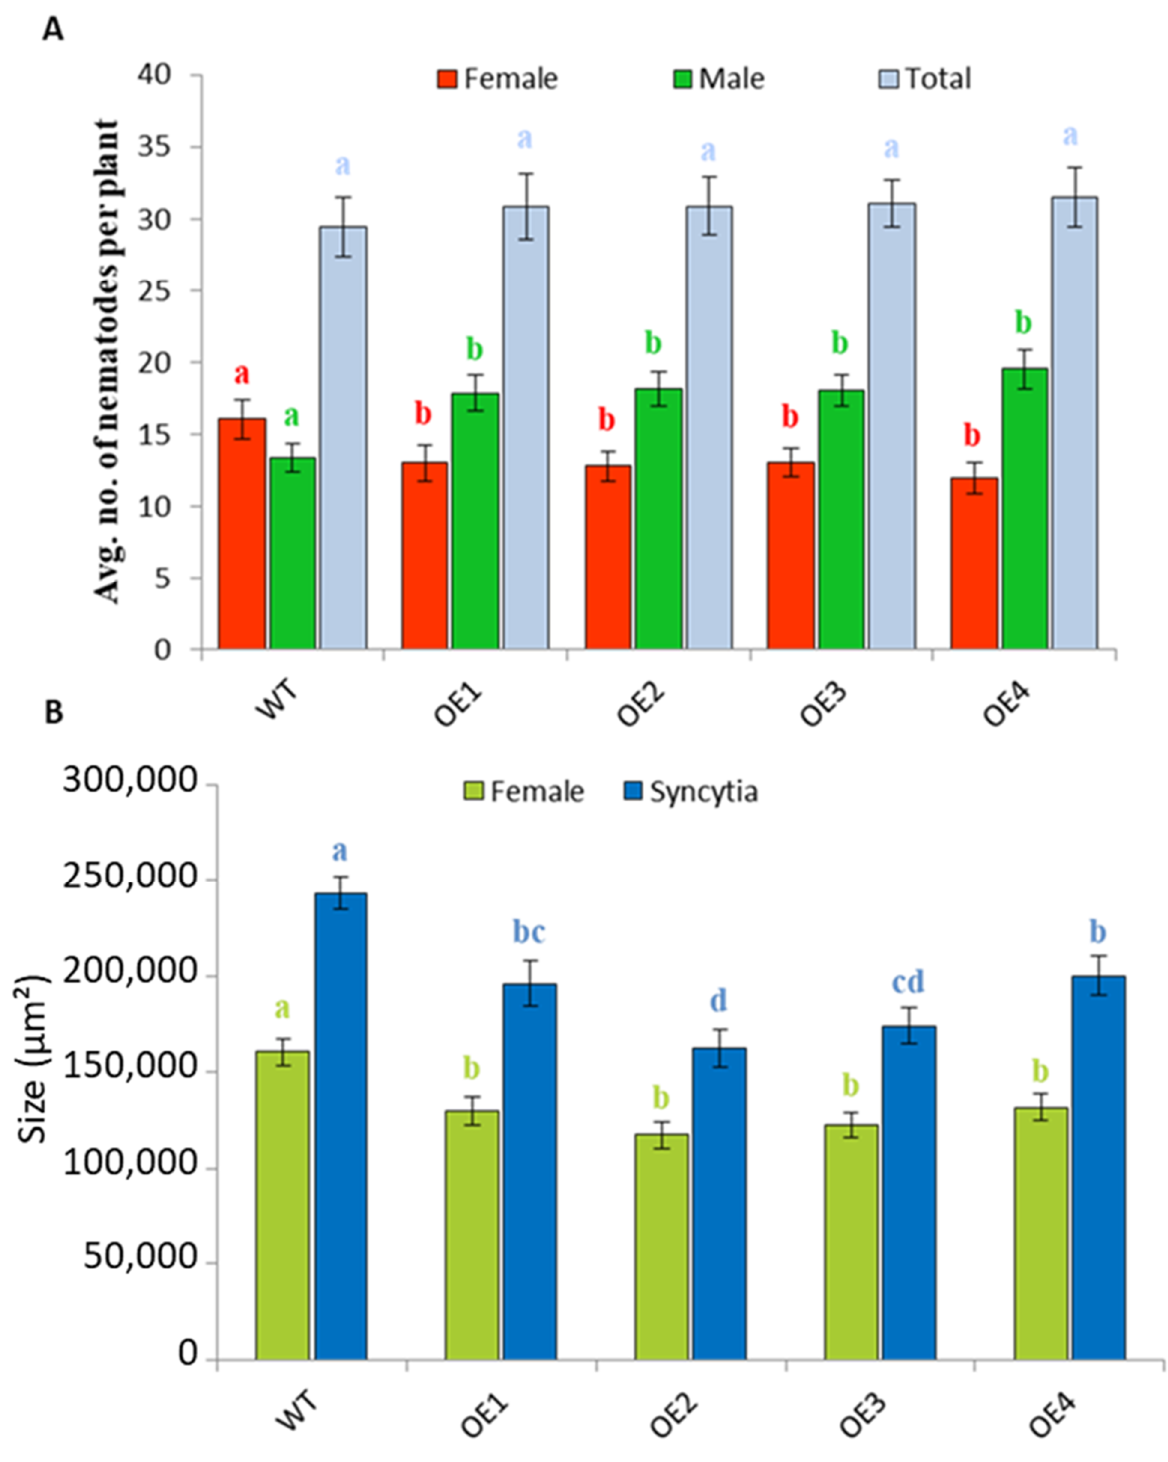
Figure 12. Overexpression of At3g59930 reduced susceptibility to H. schachtii . Twelve-day old seedlings were grown on Knop medium and infected with H. schachtii larvae. Each plant was infected with 50–60 J2 nematodes. ( A ), Male and female nematodes were counted at 15 dpi. ( B ), size of female nematodes and syncytia at 15 dpi. Mean data from three experimental replications was subjected to analysis of variance and differences among mean determined by LSD at a 5% significance level and n = 18 with different letters above the columns indicating significant differences. The values are means ± SE. WT, wild type; OE, overexpression line.